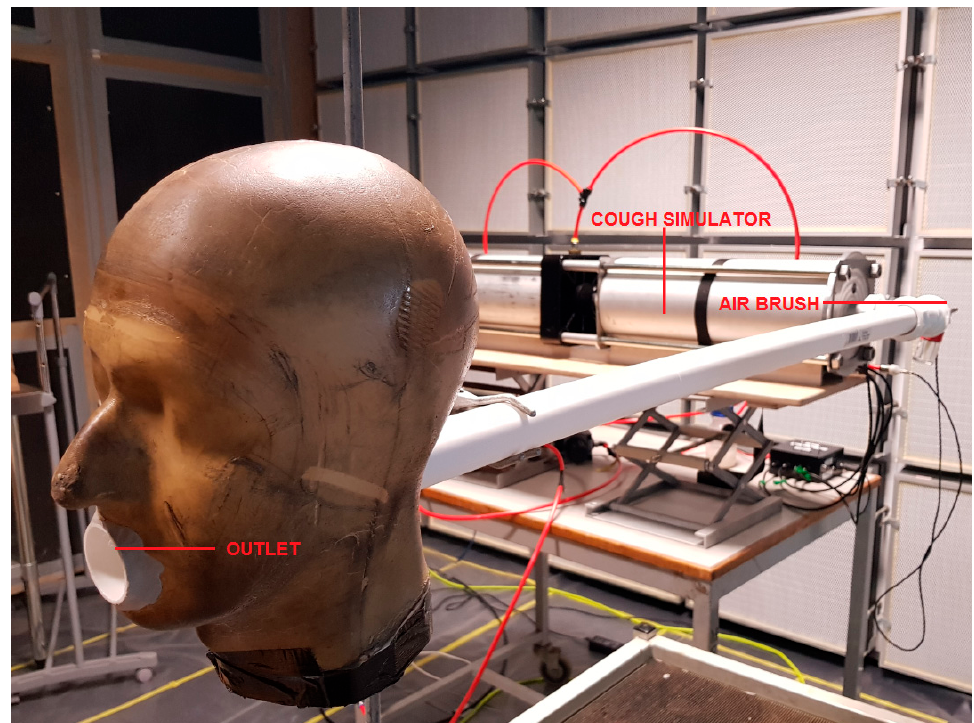
Figure 2. Experimental set up showing the cough simulator, airbrush and outlet pipe through a manikin head.